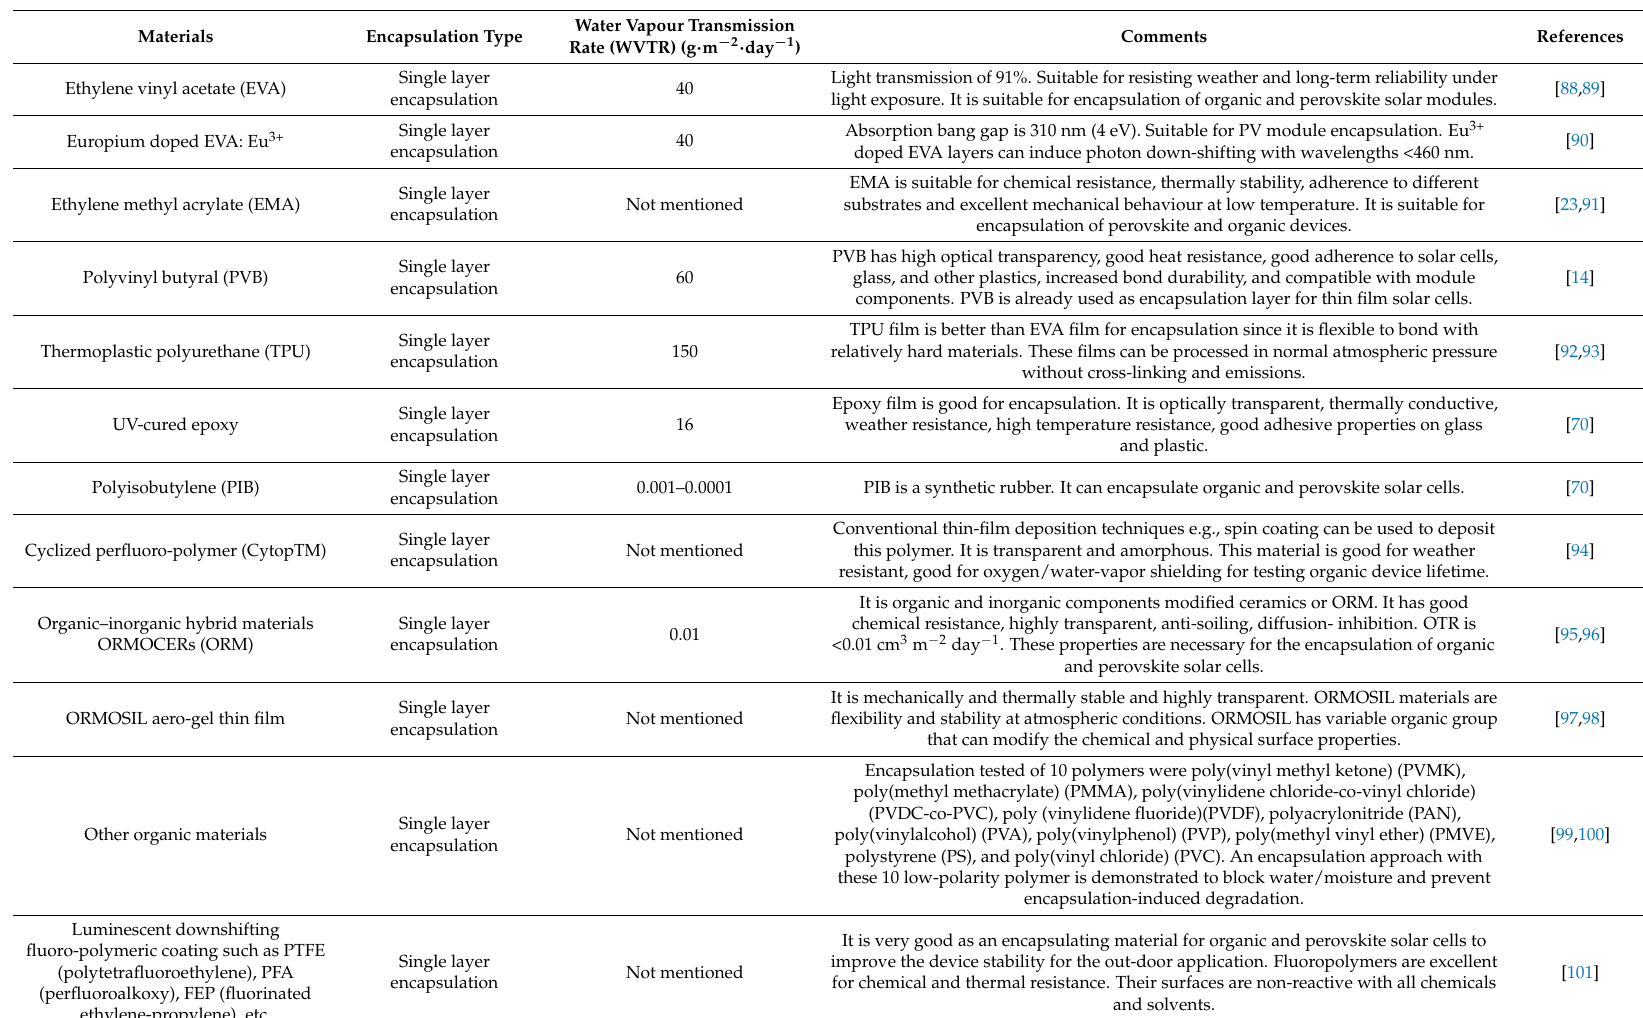
Table 2. List of probable polymer encapsulation materials for organic photovoltaic (OPV) and Perovskite